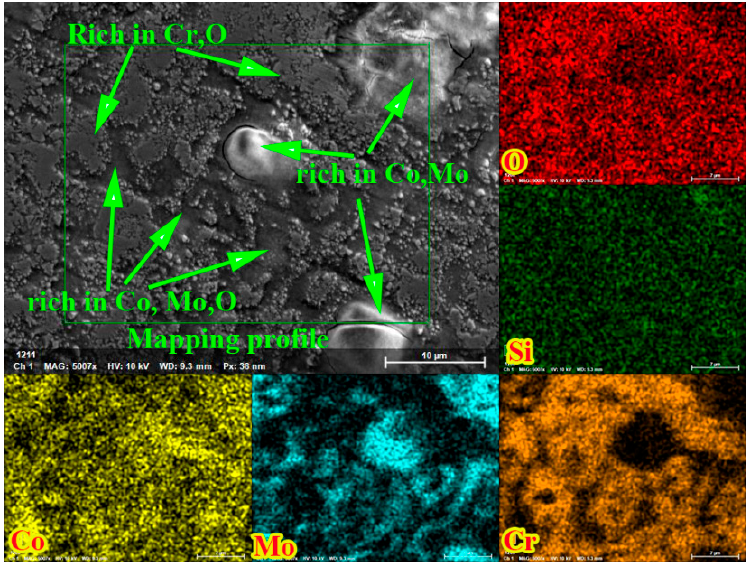
Figure 14. Elemental maps of worn surface of CoMoCrSi coating annealed for 5 h.